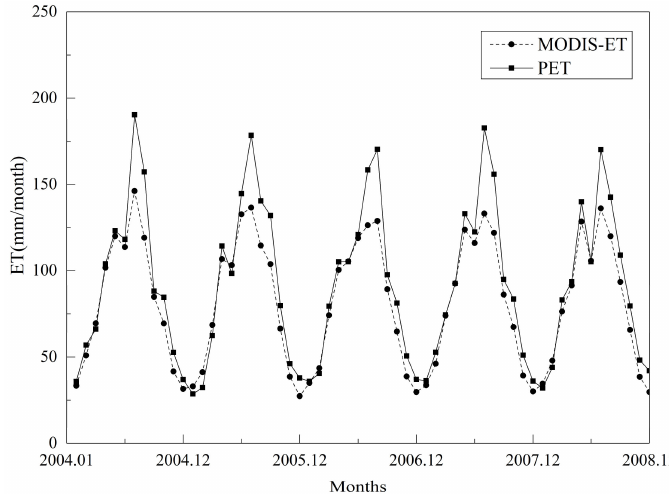
Figure 5. Monthly areal moderate resolution imaging spectrometer- evapotranspiration (MODIS-ET) and potential evapotranspiration (PET) time series of Jinhua River